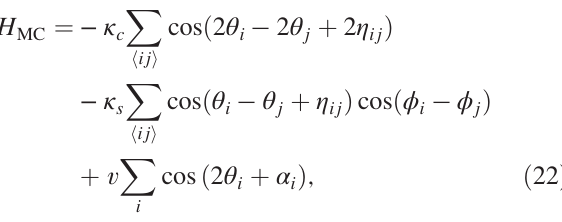
FIG. 4. Schematic phase diagram for a disordered SDW (or PDW) in 2D as a function of disorder strength v and the ratio K =K s c of the stiffnesses associated with spin waves and phonons in the absence of